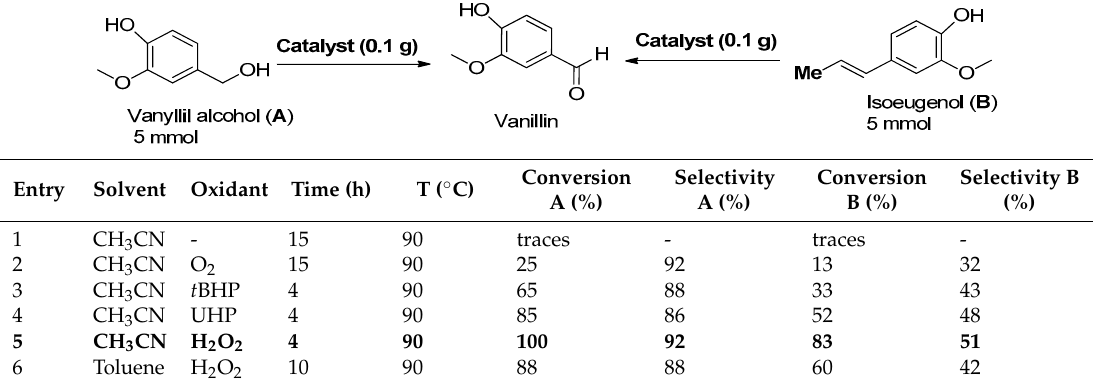
Table 2. Oxidation of vanillyl alcohol ( A ) and isoeugenol ( B ) to vanillin. (In bold: conditions for the best catalytic formance).